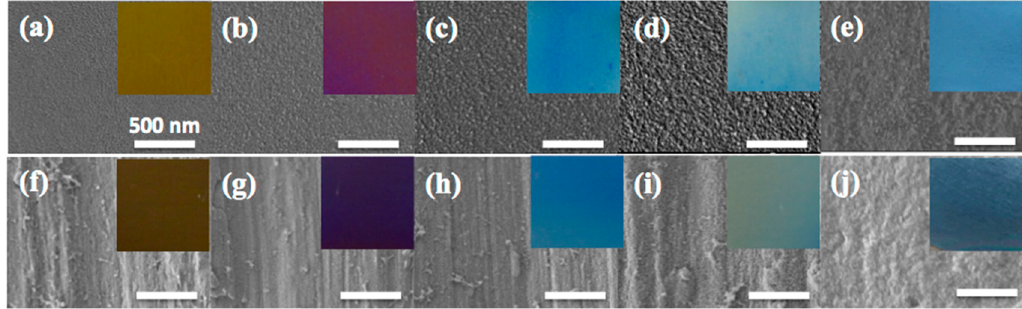
Figure 1. SEM images of the torched-titanium substrates with different reaction time. ( a – e ) polished-titanium substrates (Ti-p1, Ti-p2, Ti-p3, Ti-p4, Ti-p5), ( f – j ) rubbed by sandpaper titanium substrates (Ti-s1, Ti-s2, Ti-s3, Ti-s4, Ti-s5). ( a , f )-5 s; ( b , g )-10 s; ( c , h )-15 s; ( d , i )-20 s; ( e , j )-40 s. The inset showed the optical images of torched-titanium substrates.